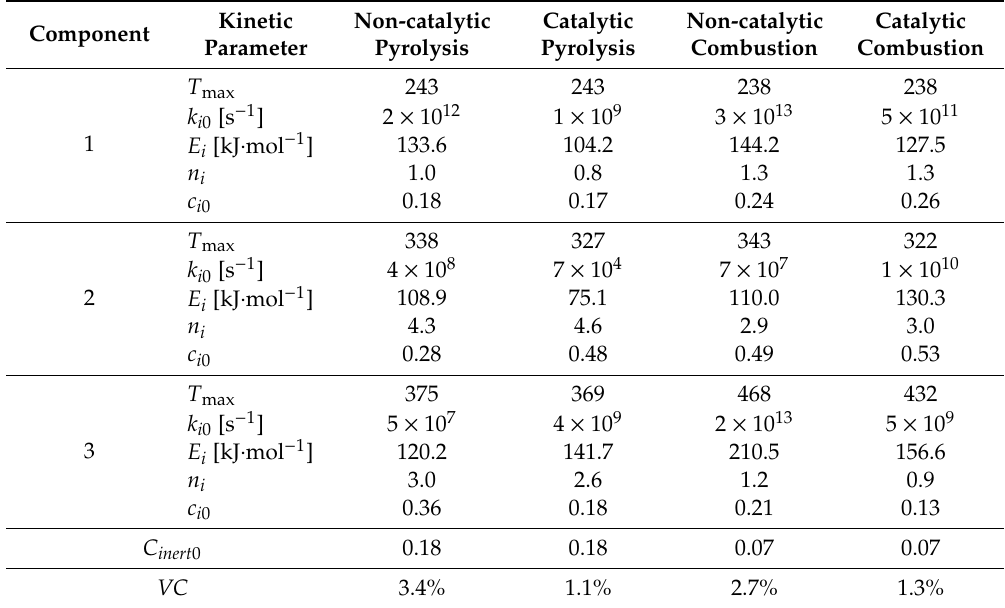
Table 4. Kinetic parameters obtained for the catalytic and non-catalytic pyrolysis and combustion of sugarcane residual